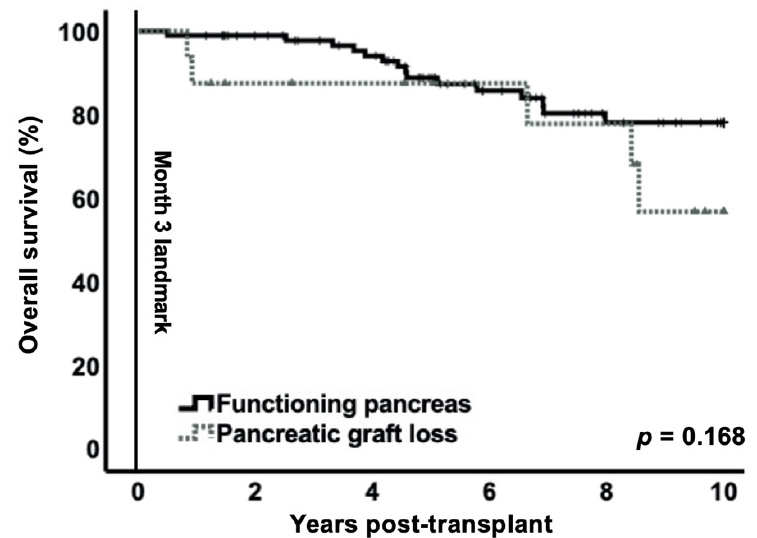
Figure 3. Patient survival over 10 years with 3-month landmark for pancreas graft loss. The Kaplan–Meier curve showed no significant difference between the two groups ( p = 0.168).